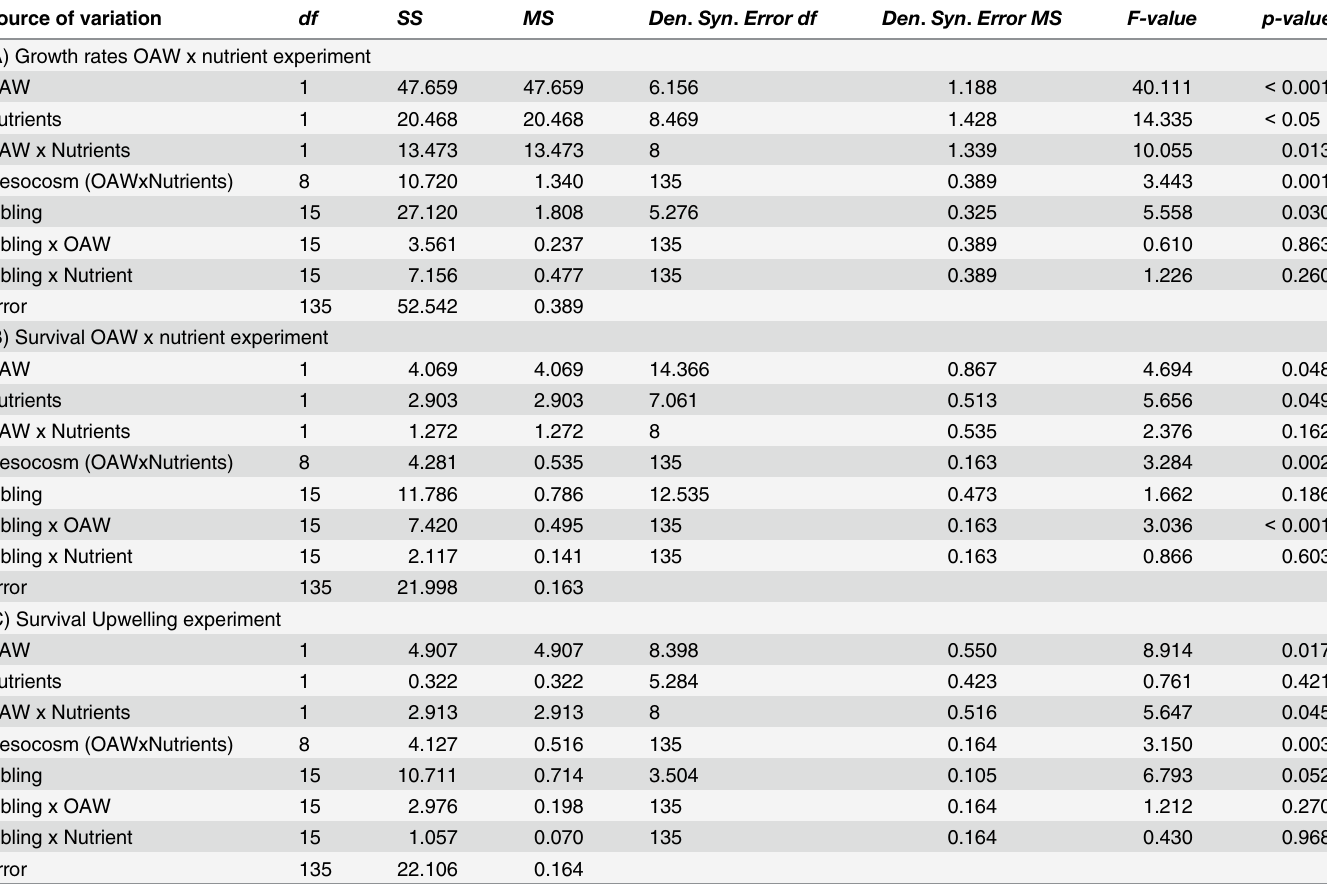
Table 2. OAW and nutrients effects on growth and survival. Results from split-plot ANOVA with the fixed factors ‘ OAW ’ and ‘ Nutrients ’ and the random factors ‘ Mesocosm ’ and ‘ Sibling group ’ . Effects are shown for (A) growth rates (% d -1 ) and (B) survival during the OAW x nutrient experiment and (C) survival during the upwelling experiment. Df: degrees of freedom, SS: sums of squares and MS: mean squares. ‘ Den. Syn. Error df ’ and ‘ Den. Syn. Error MS ’ describe the denominator synthesis of degrees of freedom and mean squares, respectively. (Datasets of area and growth values can be found in the PANGAEA